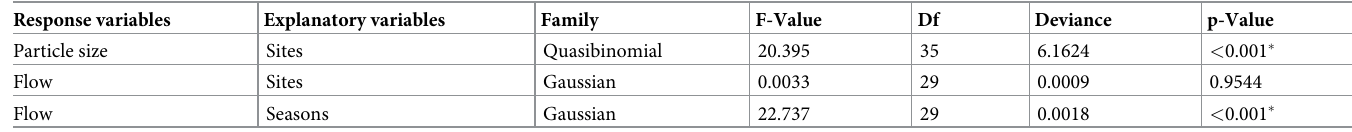
Table 2. Models of tests created for the variables of the reference stream (RS) and the degraded stream (DS) in Catal ã o, GO,